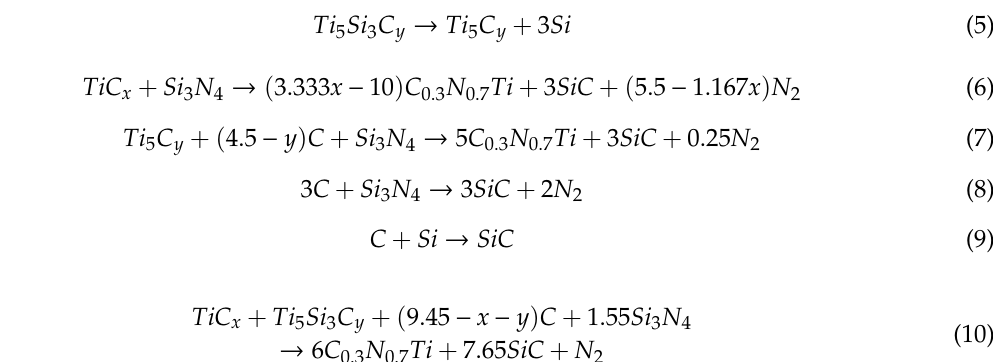
Figure 2. XRD patterns of Ti 3 SiC 2 doped Si 3 N 4 ceramics sintered at ( a ) 1600 and ( b ) 1700 °C.